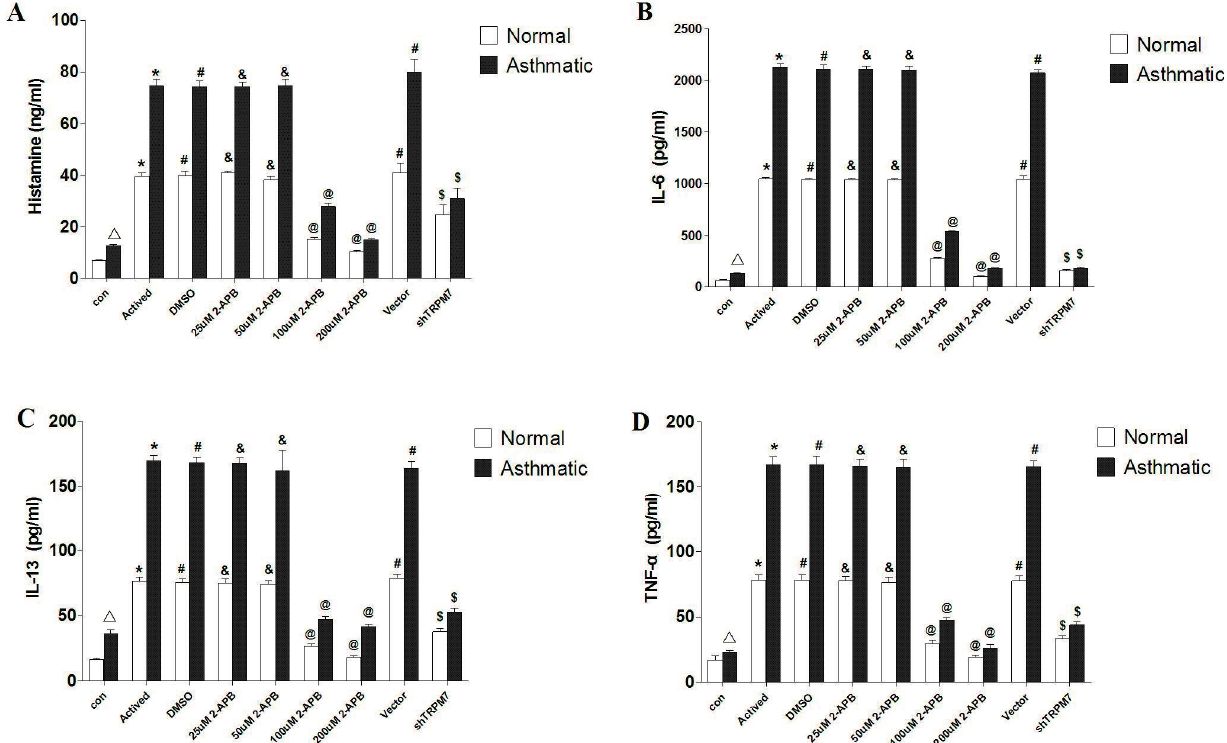
Figure 5. Levels of cytokines in rat BMMCs. ( A ) histamine; ( B ) IL-6; ( C )